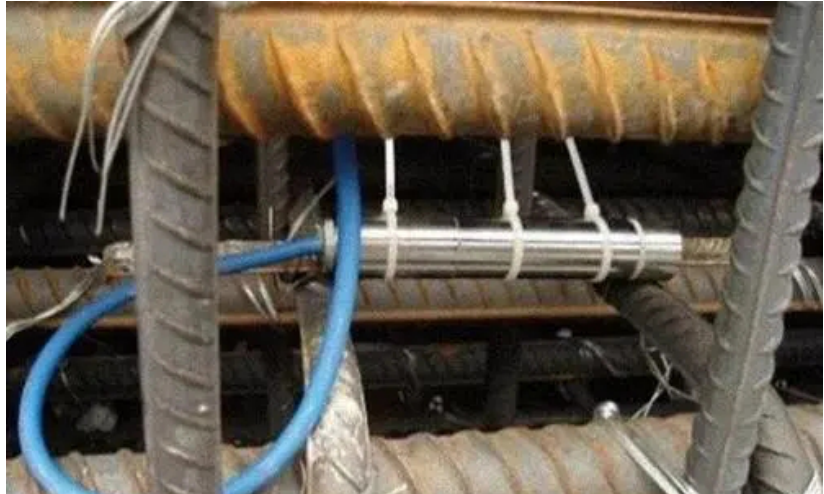
Figure 3. Actual view of an arranged vibrating wire stress transducer.